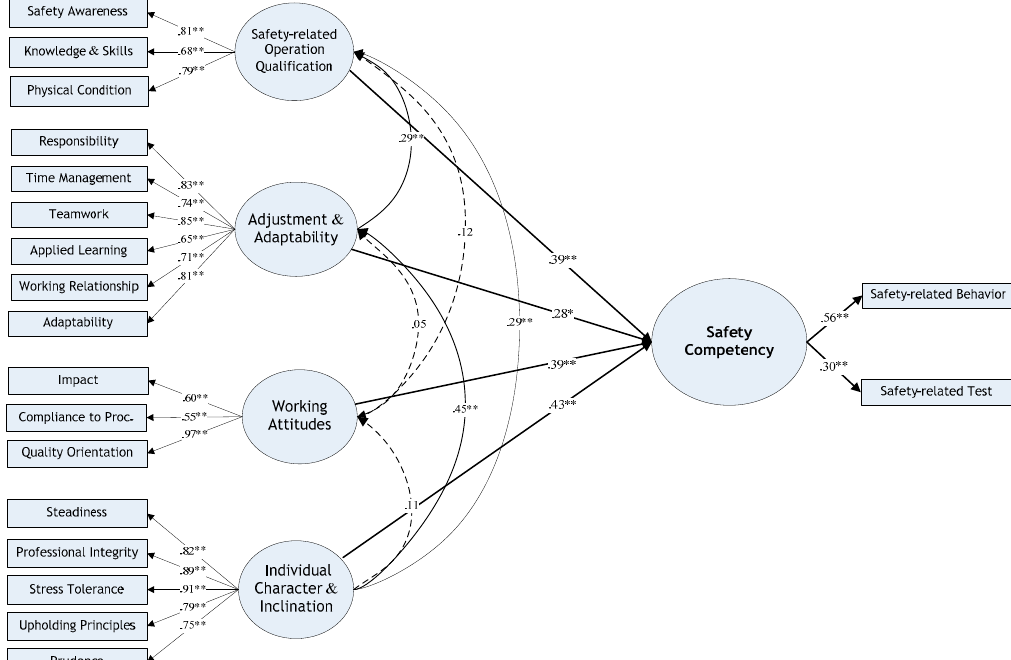
Figure 2. The Modified Hierarchical Model of Construction Workers’ Safety competency. Asterisks accompanying the coefficients indicate the significance level for each path (i.e., two asterisks indicate p < 0.01 and one asterisk indicates p < 0.05).